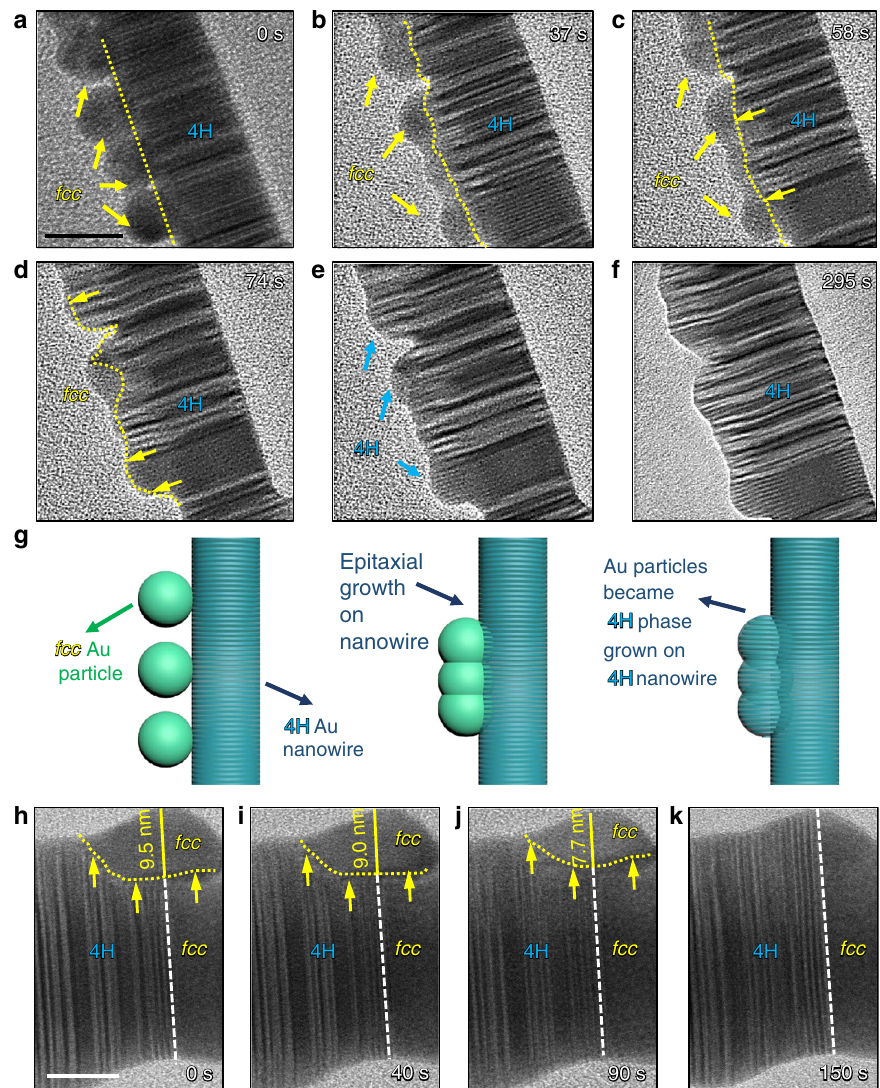
Fig. 4 In situ TEM observation of the phase transformation. a – f Atomic structure of the interface at different reaction time; the observation is performed at 300 kV with electron beam dosage of 4000 e − Å − 2 s − 1 in 1 mbar of CO gas (the scale bar in panel a is 20 nm and can apply to panel b – f ; g schematic drawing showing the fcc -to-4H phase transformation of the Au nanoparticles on 4H region of the rod; h – k in situ TEM observation of the phase transformation of a fcc – Au nanoparticle siting on the boundary between the 4H region and one fcc -end of the nanorod; experiments were performed at room temperature at 300 kV with electron dose of 2000 e Å − 2 s − 1 in 1 mbar of CO gas (the scale bar in h is 10 nm and can be applied to panel i – k